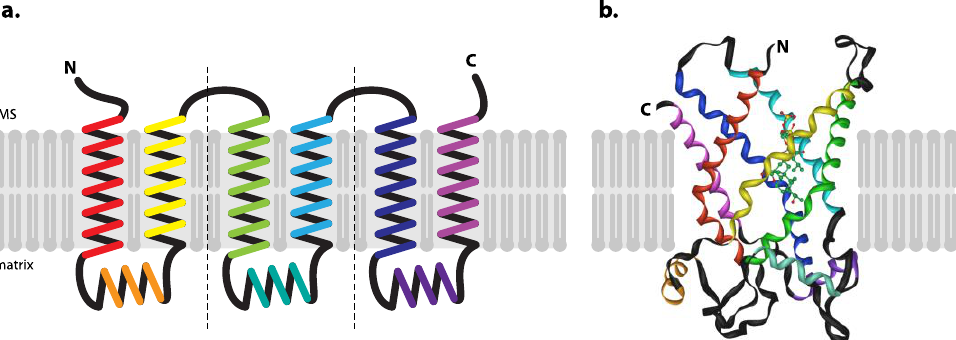
Figure 2. Structure of transporters of the mitochondrial carrier family. Mitochondrial carriers typically consist of three repetitive analogous modules. Each module, roughly 100 amino acids in length, contains two transmembrane α-helices in the matrix side connected with another short α-helix. Short hydrophilic loops connecting individual repetitive modules as well as both C- and N-termini of the protein are located in the intermembrane space (IMS) [47,48]. Depicted are ( a ) a schematic of membrane topology and ( b ) a 3D structure of bovine ADP/ATP carrier (AAC1). Same colour coding is used in both panels. The 3D model was generated by iMol 0.40 software using structural data from [49]. Molecule of the inhibitor, carboxyatractyloside, bound to the carrier is shown as a balls-and-sticks model.